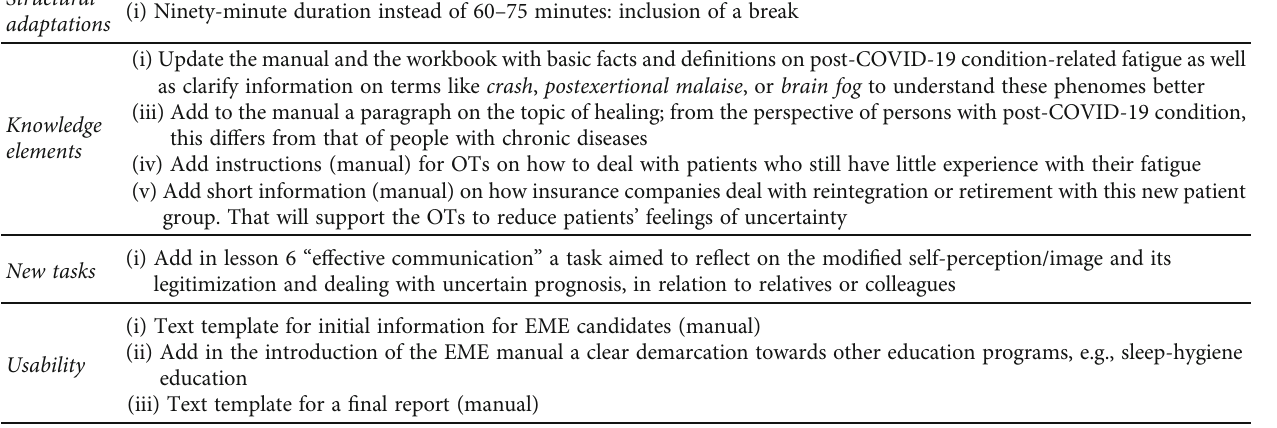
Table 3: List of recommendations and